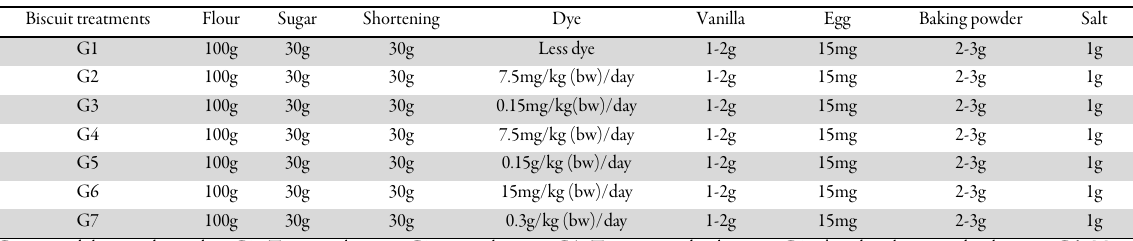
Table 1. Formula of biscuit (wheat and barley) flour preparation Biscuit treatments Flour